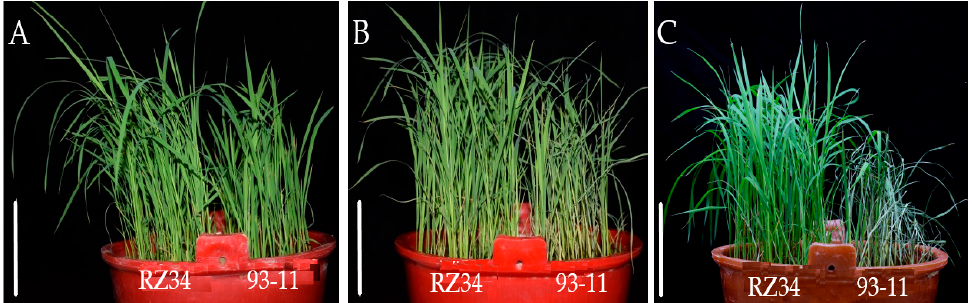
Figure 6. Cold stress treatment to RZ34 and 93-11 at seedling stage. ( A ) Before cold stress (bar = 10 cm); ( B ) after cold stress (bar = 10 cm) and ( C ) after three days of recovery (bar = 10 cm).